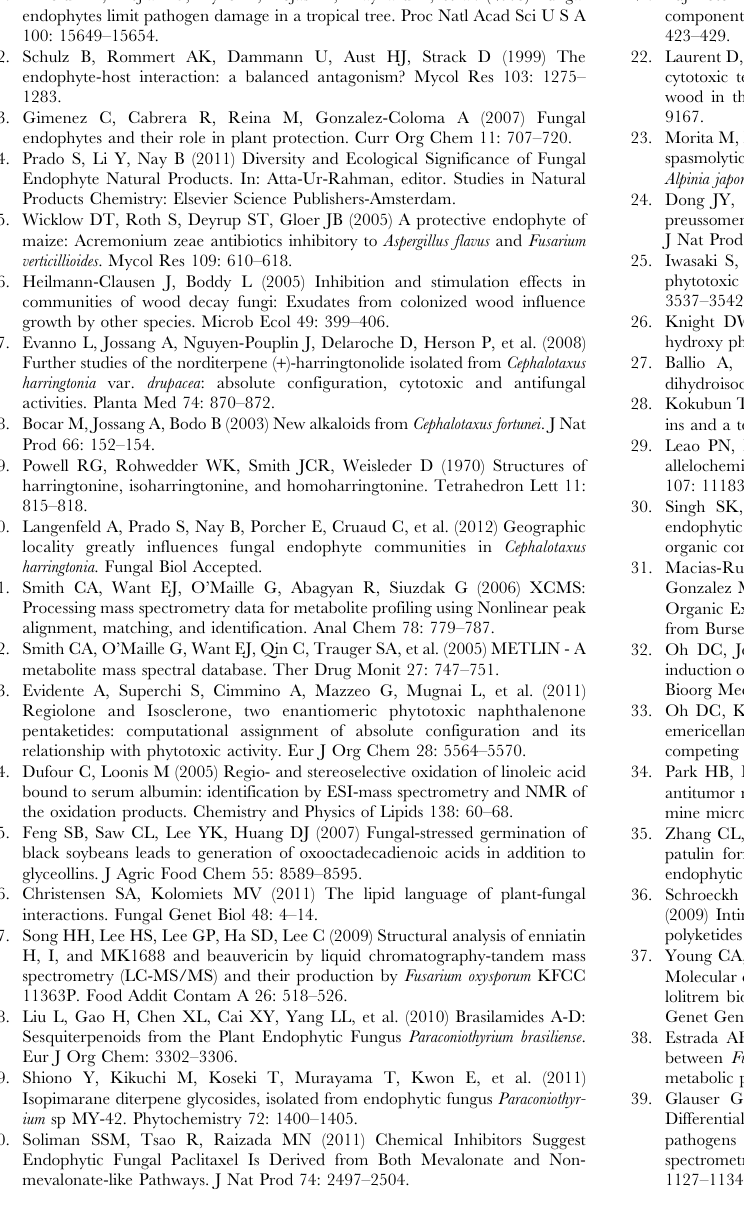
Figure S2 Fragmentations spectrum of the positive ion m / z = 784.4. This identified as beauvericin and some of the putative structures of the fragments are